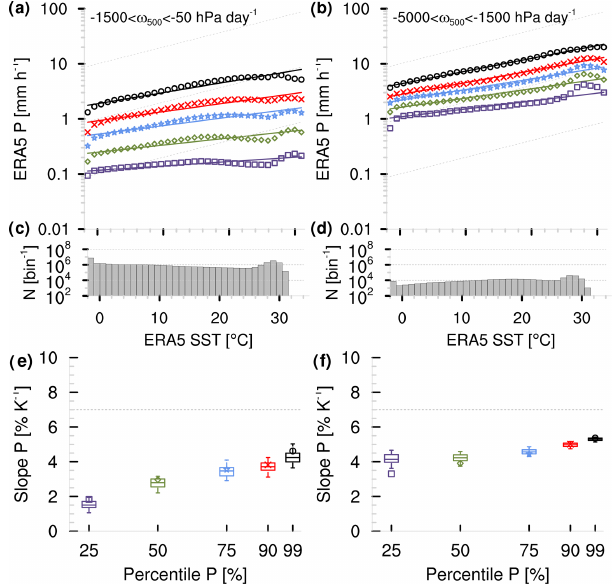
Figure 6. As with Fig. 5 but for the complete ERA5 period. Panels (a) , (c) and (e) are constrained by − 1500 < ω 500 < − 50hPad − 1 and panels (b) , (d) and (f) by − 5000 < ω 500 < − 1500hPad − 1